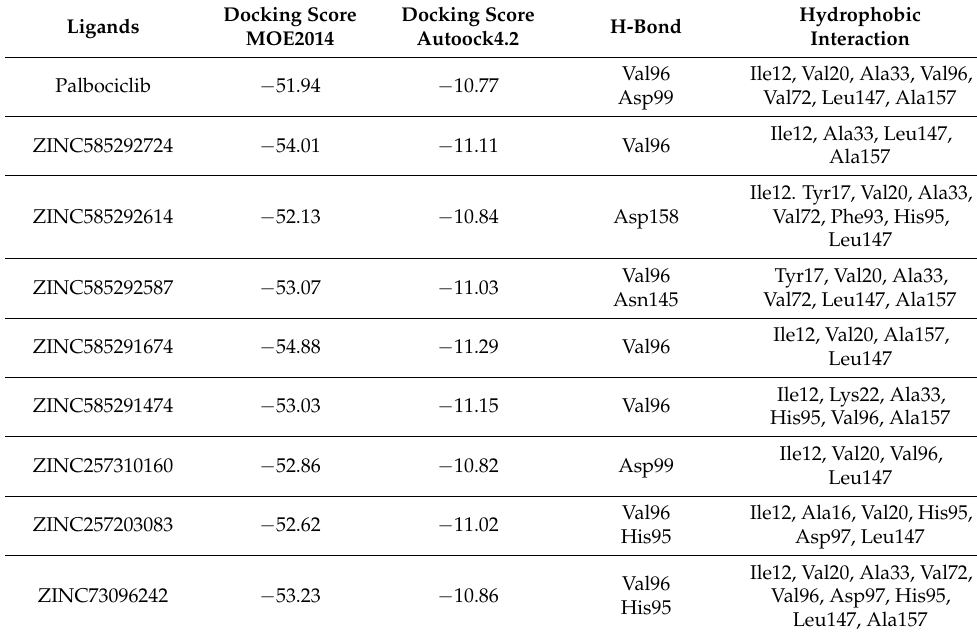
Table 2. The CDK4–ligand interactions recorded during